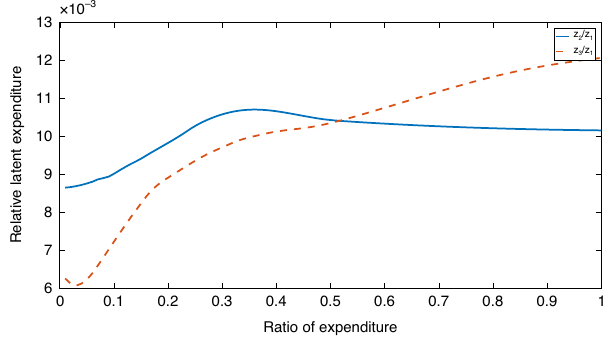
Fig. 5 Expenditure modes compared. Relative normalized expenditure under individual heads plotted against the relative total expenditure (the normalized summation of cereal, other food, and non food expenditures); z 1 represents the projection weights for cereal expenditure while z 2 and z 3 , respectively, represent projections weights for other-food and non-food- based